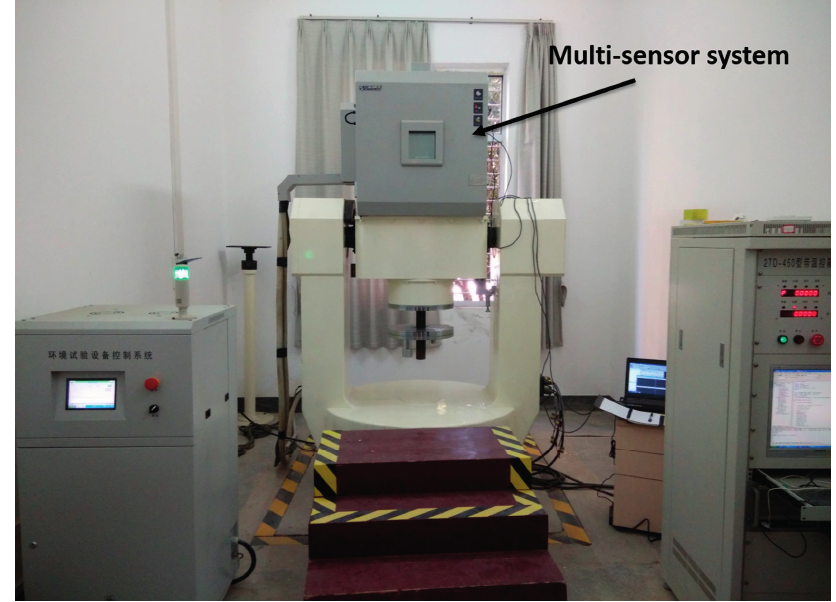
Figure 5. Two-axis turntable for testing multi-sensor system.